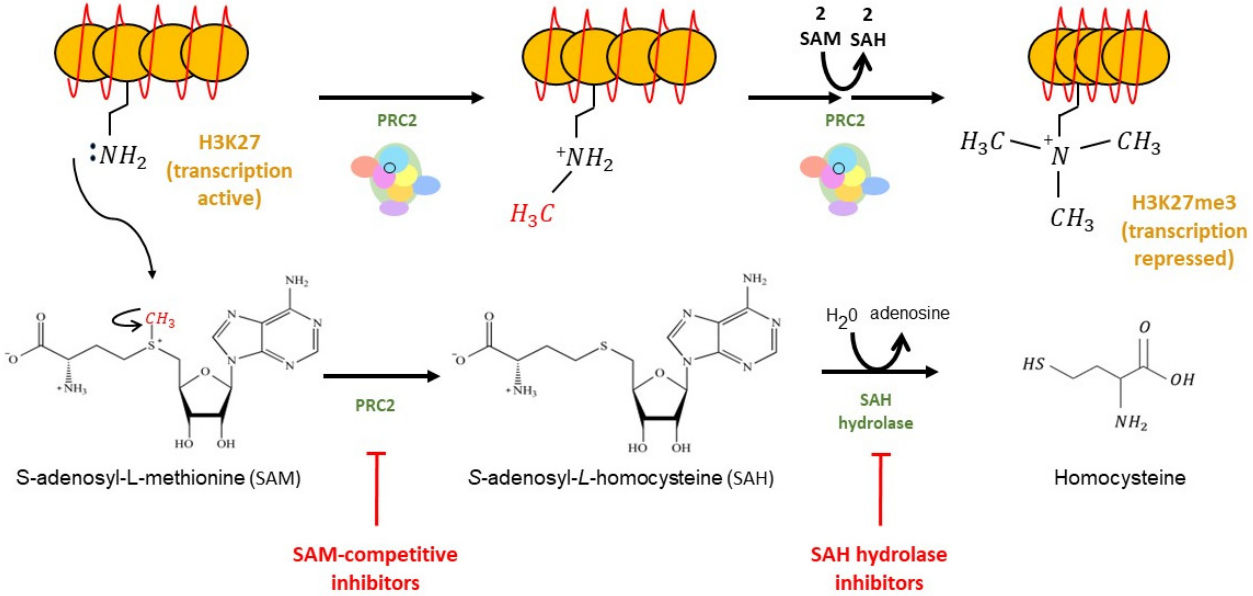
Figure 2. Model of H3K27 methylation by PRC2. PRC2 catalyzes the nucleophilic attack of the SAM cofactor, resulting in the transfer of the methyl group (in red) from SAM to the lysine residue of H3K27. This transfer repeats two more times to produce a tri-methylated lysine-27 residue of his- tone 3 (H3K27me3), which ultimately results in a more tightly packed heterochromatin complex that represses gene transcription. SAH is further metabolized into adenosine and homocysteine via SAH hydrolase. The catalytic subunit (EZH2) of PRC2 and SAH hydrolase can be inhibited by SAM- competitive inhibitors and SAH hydrolase inhibitors, respectively. SAM: S -adenosyl-L-methionine; SAH: S -adenosyl-L-homocysteine.